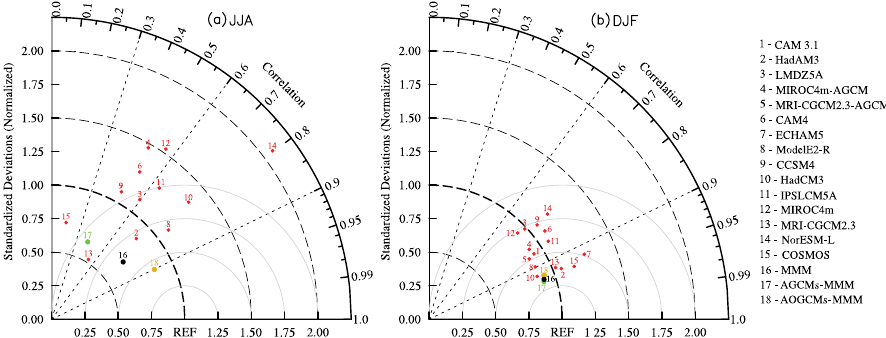
Fig. 2. Taylor diagrams of (a) summer and (b) winter meridional wind at 850hPa in the East Asian regions of 20–45 ◦ N and 105–135 ◦ E for different models. The point REF indicates the NCEP-DOE reanalysis data averaged within 1979–2008 (Kanamitsu et al., 2002). The model results (CAM3.1, MRI-CGCM2.3-AGCM and ECHAM5) with negative SCC in (a) are not shown. In the Taylor diagram, the standard deviation of the modeled field is the radial distance from the origin. The RMSE is the distance to the point REF. The azimuthal position gives the SCC. The RMSE and the modeled standard deviation are normalized by the observed standard deviation.